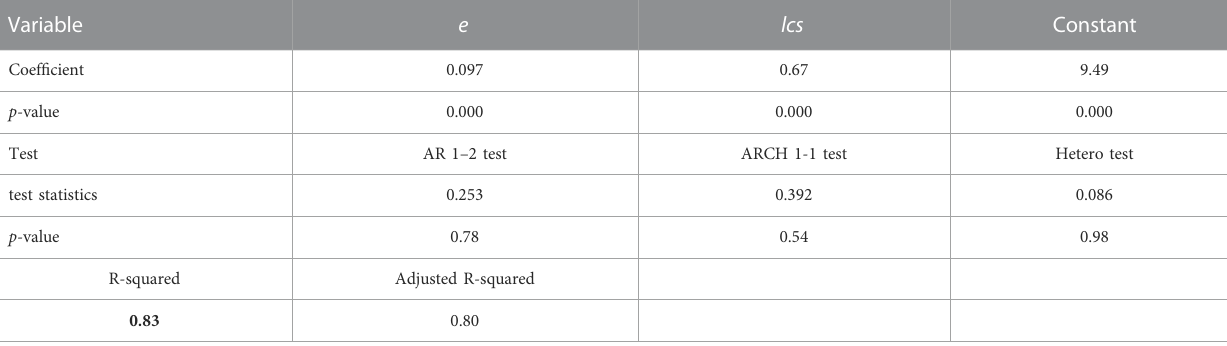
TABLE 6 Estimation results of the Gets approach in dynamic